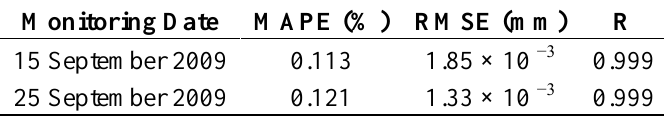
Table 3. Statistical performance monitoring check